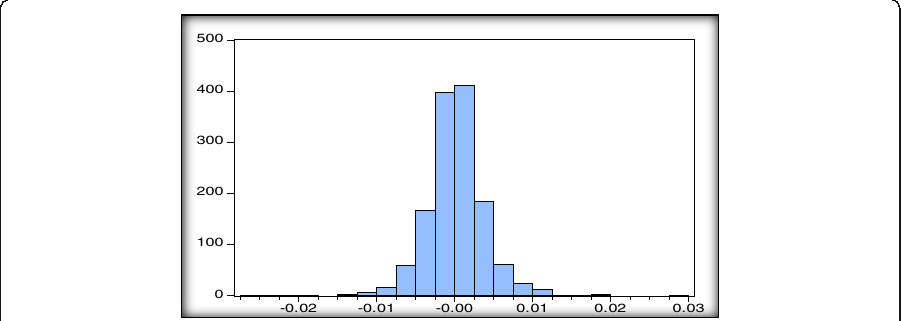
Fig. 1 Histogram representing the difference in log price of SBI GETF. In the histogram, the horizontal axis represents the difference in log price and the vertical axis represents the number of times each value occurs, i.e.: it is the probability density function of the difference in log price of SBI